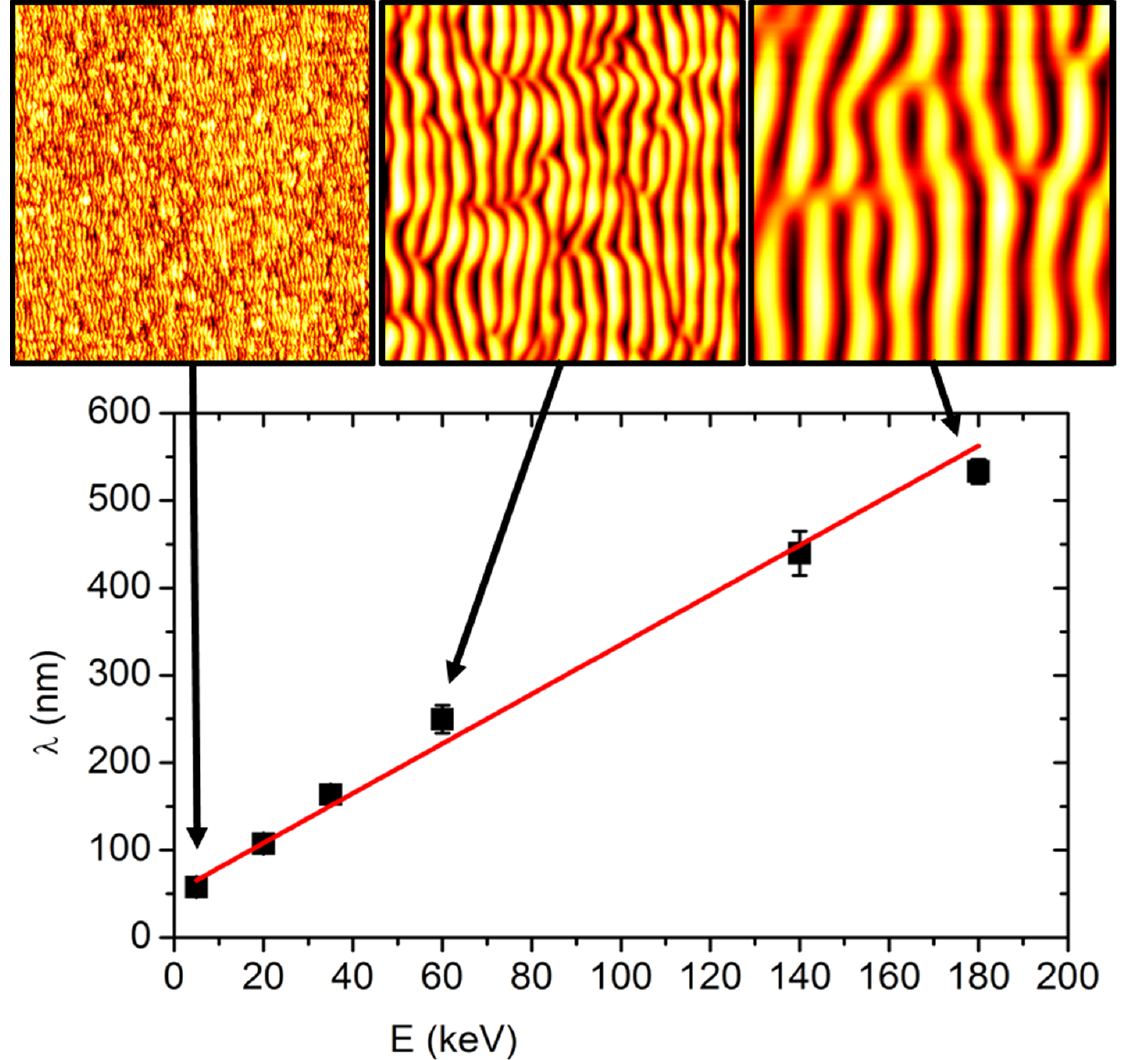
Figure 2. Ripple periodicity λ as a function of ion energy E with corresponding AFM images. The nanopatterns were generated by irradiation of Si surfaces with Xe + ions at room temperature and 65 ◦ incidence with respect to the surface normal. The applied fluence was 2 × 10 17 cm − 2 . The red line is a linear fit to the data. The AFM images have a size of 4 × 4 µm 2 .